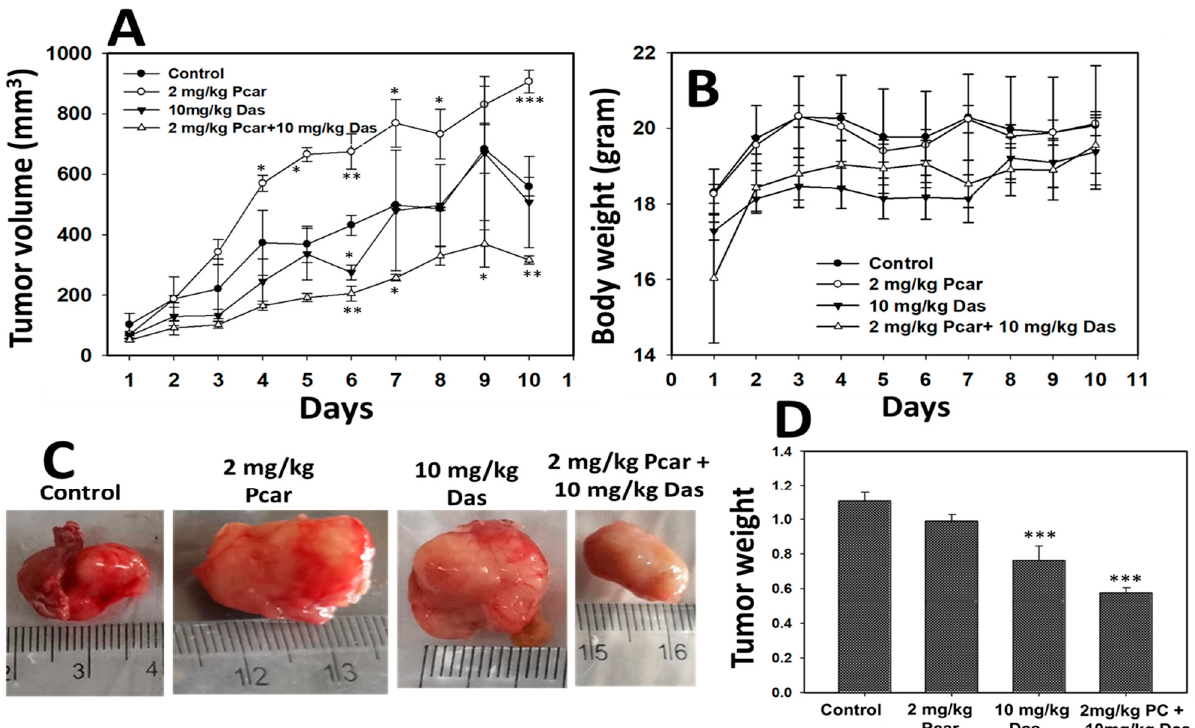
Figure 8. Pcar and Das combined treatment shows anti-tumor in vivo activity. ( A ) Mouse tumor volume decreases significantly in Pcar and Das combination treatment group compared to single- treated and control groups. ( B ) Bodyweight of mice does not change in response to combined or single-drug treatment. ( C ) Representative images showing mouse tumors of each group. ( D ) Result shows a decrease in the tumor weight of the Pcar and Das combination treatment group compared to the single-treated and control groups. Data represented as mean ± standard error (SE) obtained from three ( n = 3) different experiments, * p < 0.05, ** p < 0.01, *** p < 0.001.